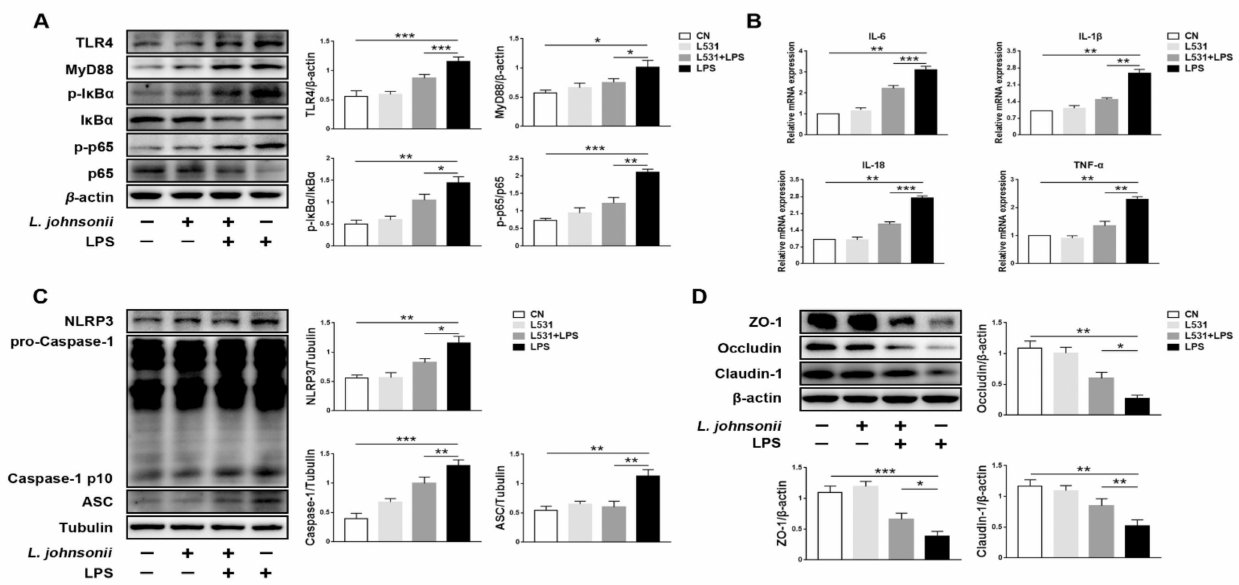
Figure 6. L. johnsonii L531 alleviates LPS-induced inflammatory response in IPEC-J2 cells. ( A ) Western blotting of TLR4, MyD88, p-I κ B α , I κ B α , p-p65, and p65. ( B ) Pro-inflammatory cytokines mRNA expression levels in IPEC-J2 cells were detected by qRT-PCR. ( C ) Western blotting of NLRP3, ASC, Caspase-1. ( D ) Western blotting of ZO-1, Occludin, Claudin-1. CN (Control), L531 ( L. johnsonii L531), LPS (lipopolysaccharide). The panels show proteins or cytokines quantification using ImageJ software (version 1.50). The values are shown as the mean ± SEM; n = 3. * p < 0.05, ** p < 0.01, *** p <